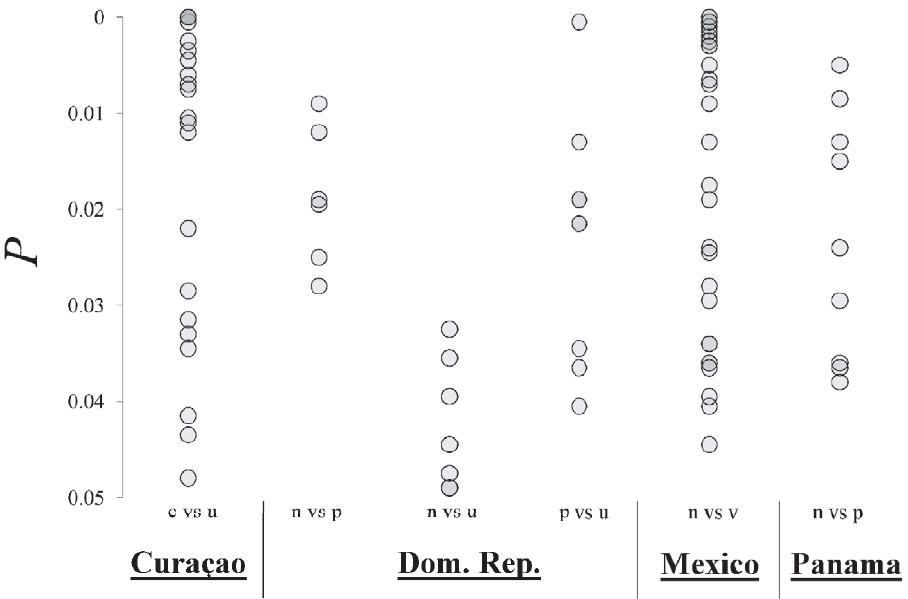
Figure 2. P values for outlier loci produced by comparisons of sympatric Hypoplectrus morphotype AFLPs. Only comparisons with suitable sample sizes are shown. See table S7 for loci and outlier numbers for all comparisons. Abbreviations represent the morphotypes included in each comparison: c= H. chlorurus , n= H. nigricans , p= H. puella , u= H. unicolor , v=Veracruz white. doi:10.1371/journal.pone.0020394.g002 PLoS ONE |